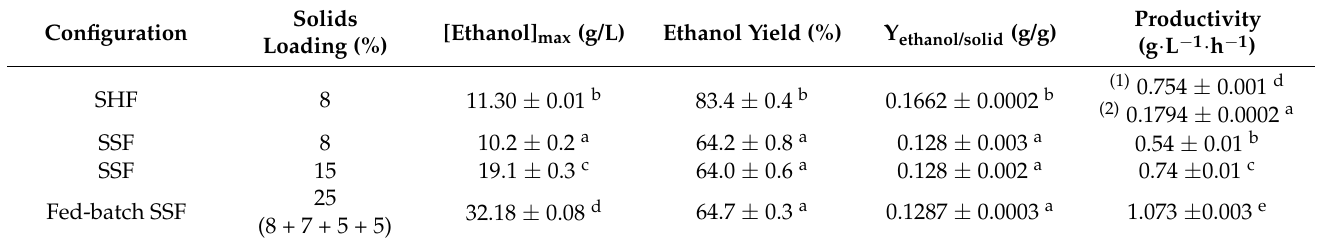
Table 3. Parameters obtained in SHF and SSF of subW-pretreated BSG at different solids’ loadings with Ethanol Red ® . Analytical measurements were conducted in triplicate. Values are expressed as the mean ± standard deviation from triplicate